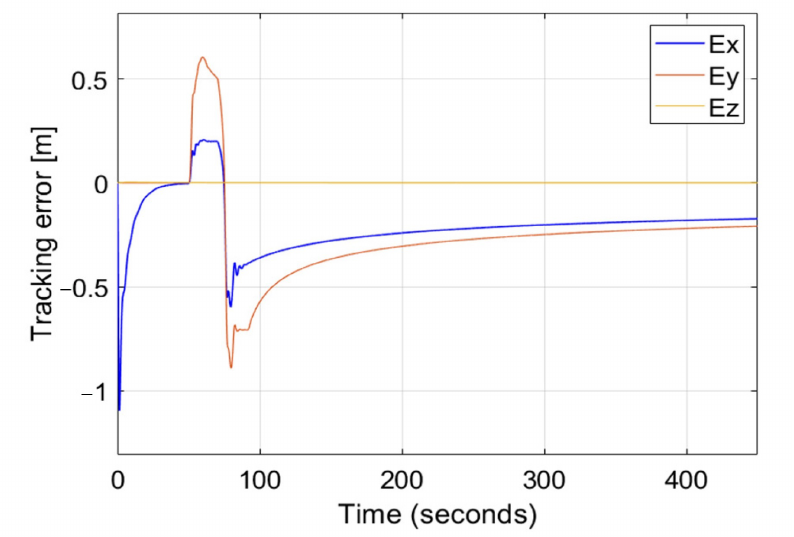
Figure 11. Time plots of position tracking errors for the nonlinear PID controller in the case of simultaneous longitudinal and lateral wind gusts. Applied values of coefficients are as follows: α = 10, β = 10, γ = 10, δ Ix 1 = δ Ix 2 = δ Iy = δ Iz = 1 and δ Dx 1 = δ Dx 2 = δ Dy = δ Dz =